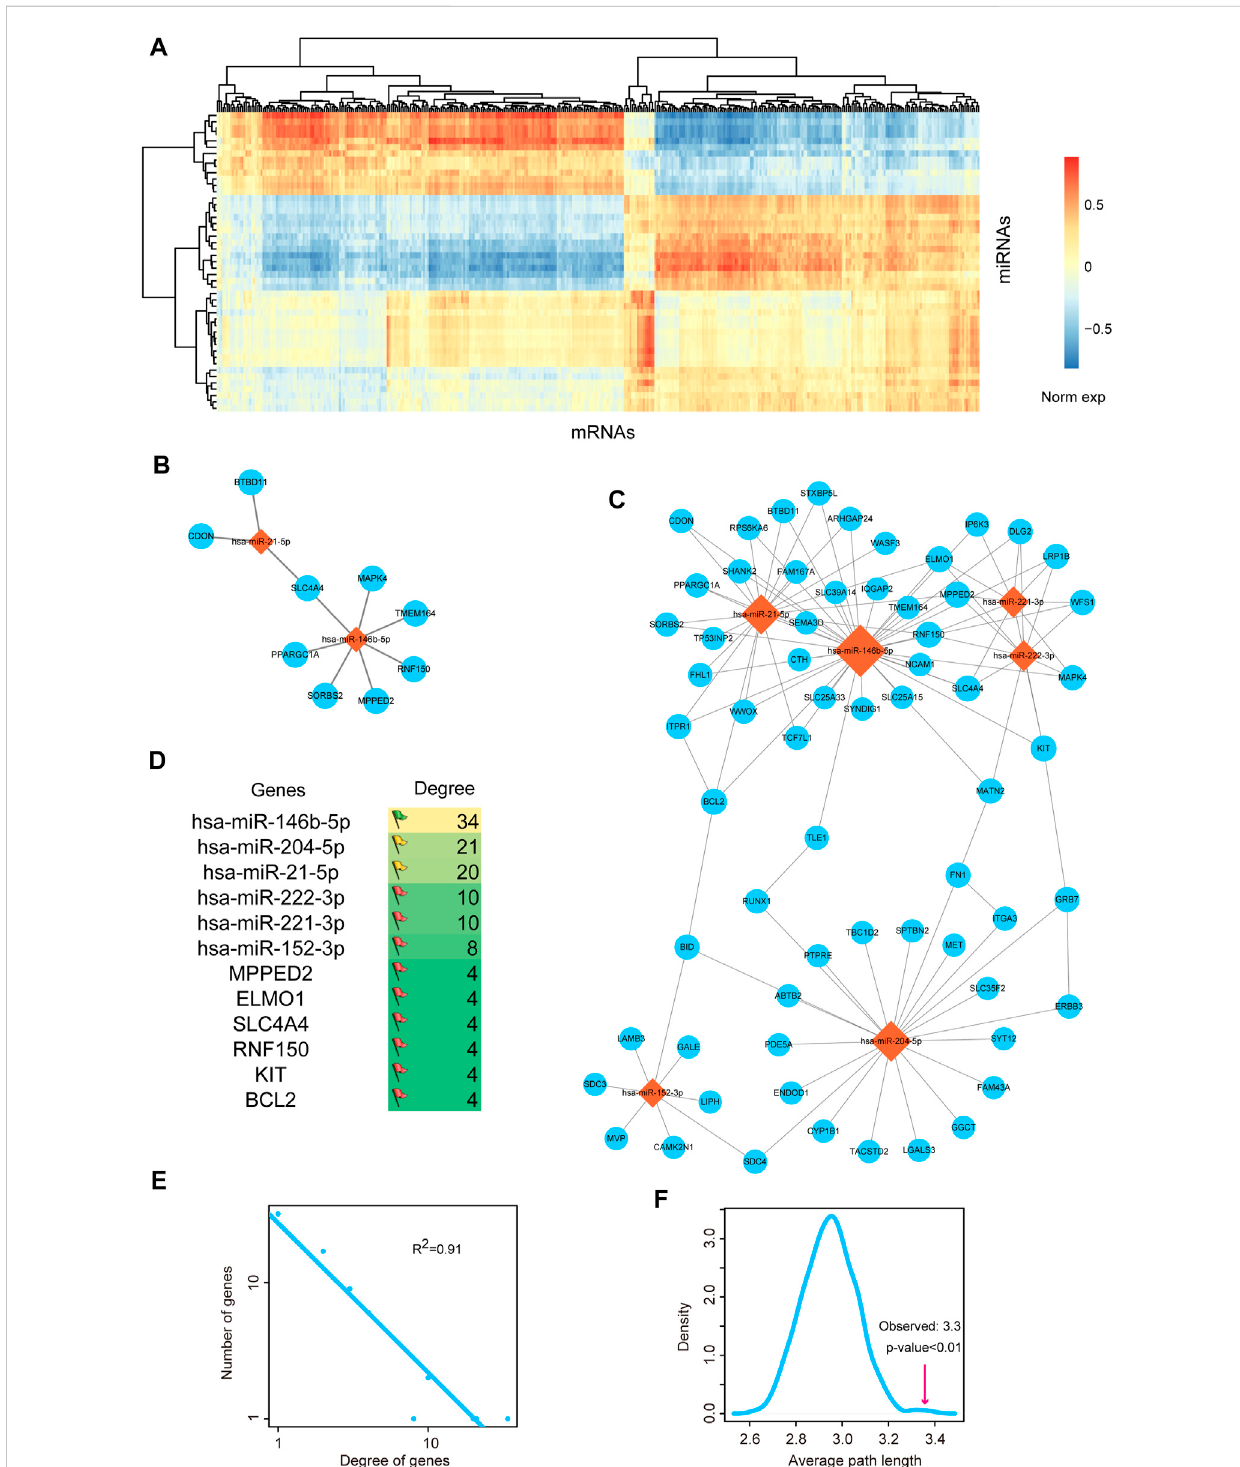
FIGURE 2 Analysis of miRNA-mRNA network. (A) The heat map of correlations between DE miRNAs and DE mRNAs. (B) The most negatively expression- correlated10DEmiRNA-DEmRNAinteractionpairs. (C) TheTHCA-relatedmiRNA-mRNAnetwork.OrangediamondrepresentsmiRNAandbluecircular represents mRNA. Node size represents degree of node. (D) The top 6 high-degree miRNA nodes and mRNA nodes of the network. The colors of fl ags represent the degree of miRNAs. Degree is de fi ned as the edges that link to the nodes. (E) Degree distribution of the network. All nodes follow a power-law distribution. This curve indicated that the network was a scale-free network and could be used to identify important nodes. (F) Average path length of the real network was signi fi cantly shorter than that of 1,000 random networks. The pink line represents the average path length of the real network. Curve was plotted by summarizing the path length distributions of the 1,000 random